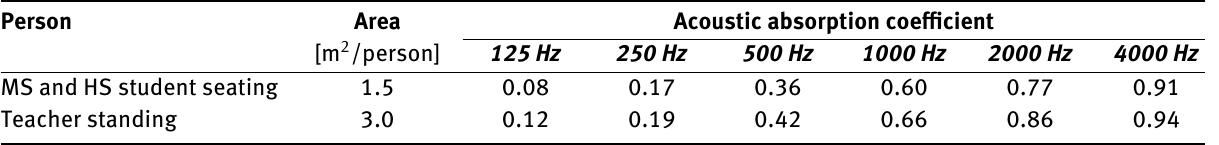
Table 9: Acoustic absorption areas and coeflcients for people in the school. Person